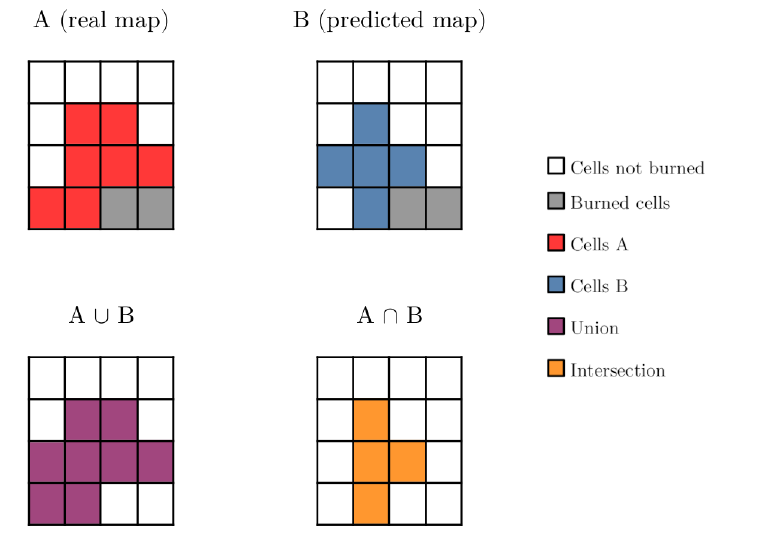
Figure 6. Example of the fitness computation with Equation (3). We have that | A ∪ B | = 8, and | A ∩ B | = 4; then fitness ( A , B ) = 4/8 =